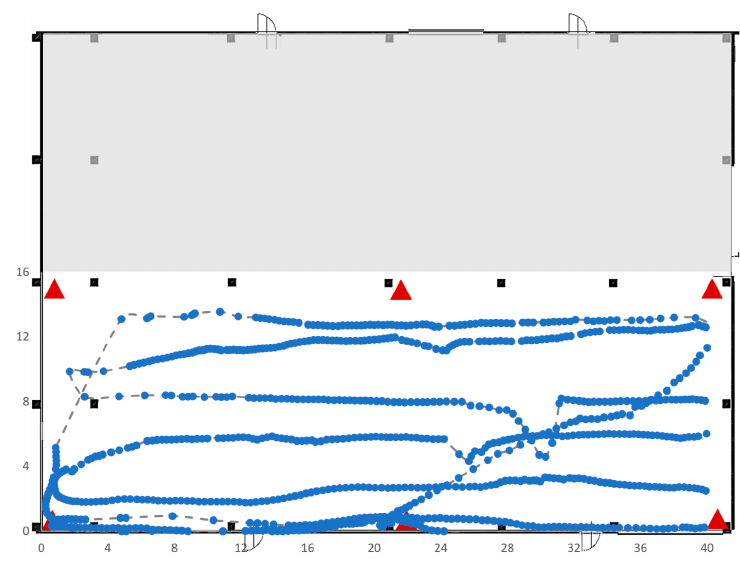
Figure 22 . Trajectory followed by the tag of Test 5. Figure 22. Trajectory followed by the tag of Test 5.